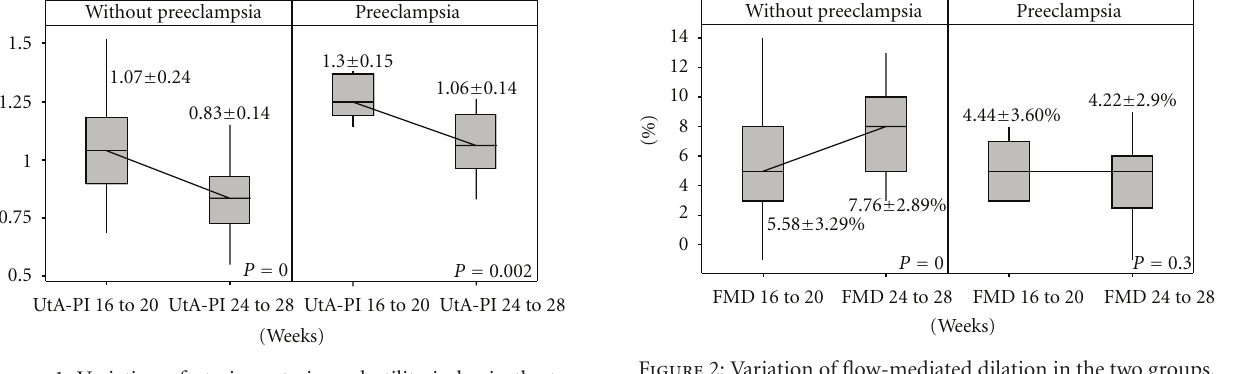
Figure 1: Variation of uterine arteries pulsatility index in the two groups.